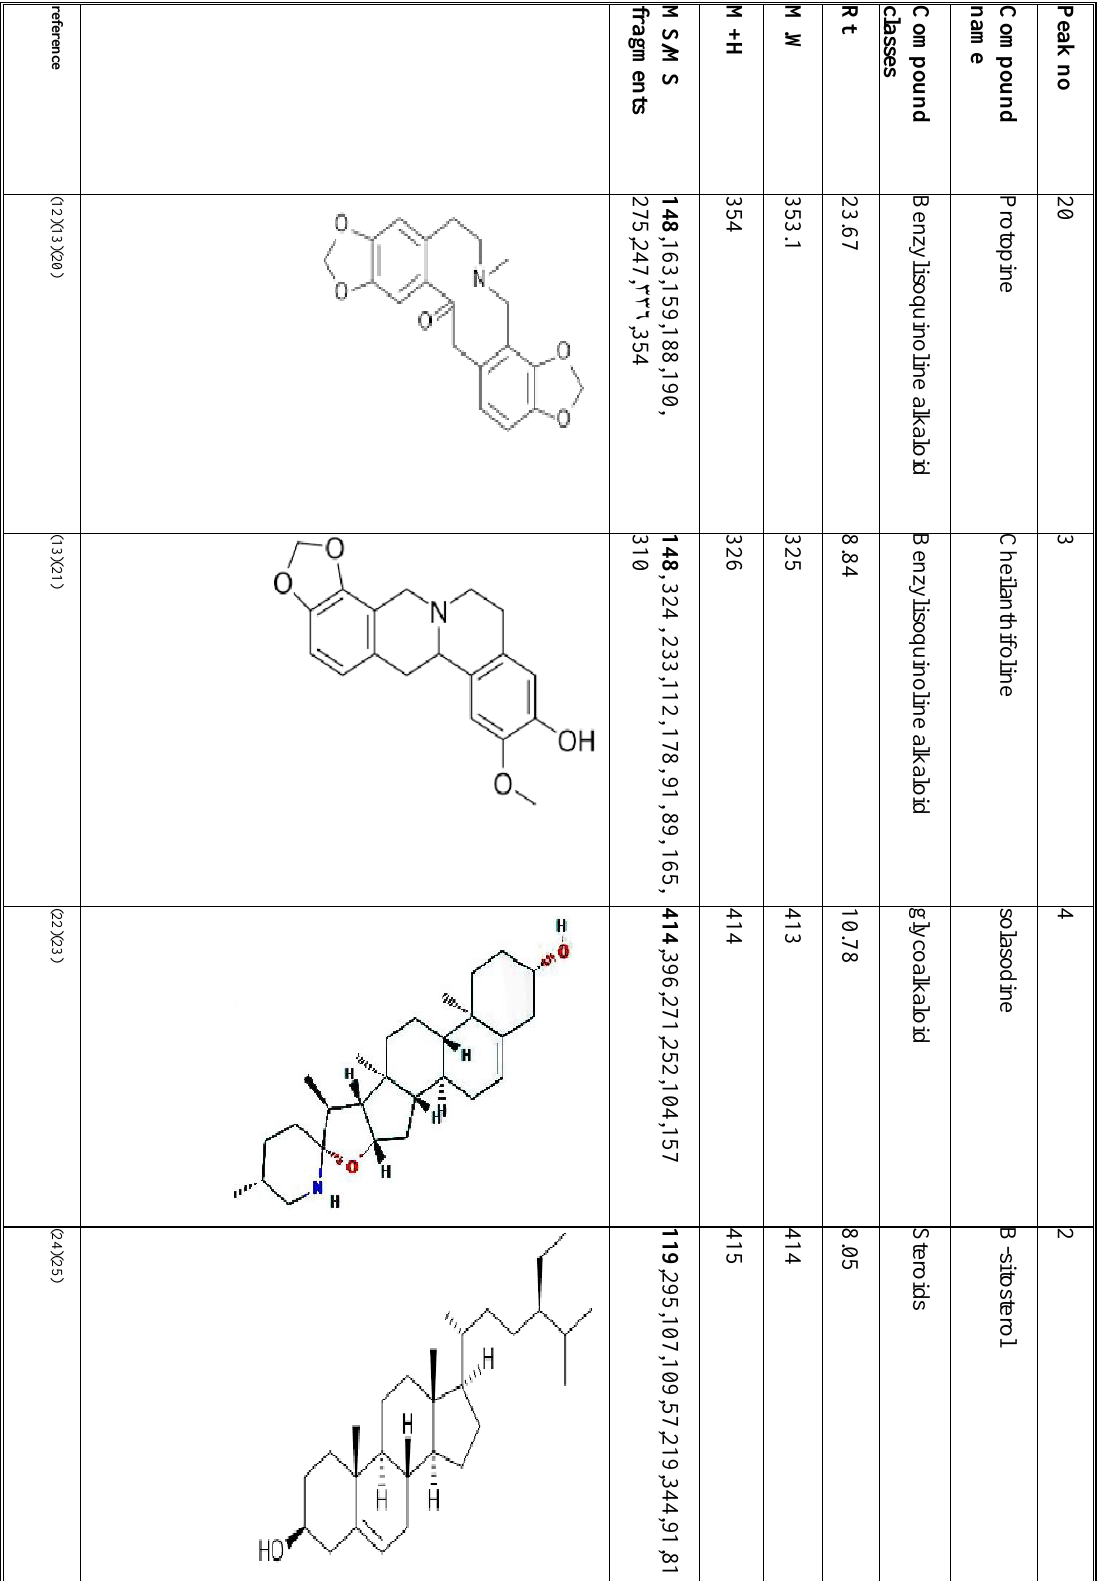
Table 4. Identification result by UPLC-ESI-MS/MS fragmentation of chloroform fraction (number in Bold line represent base peak)